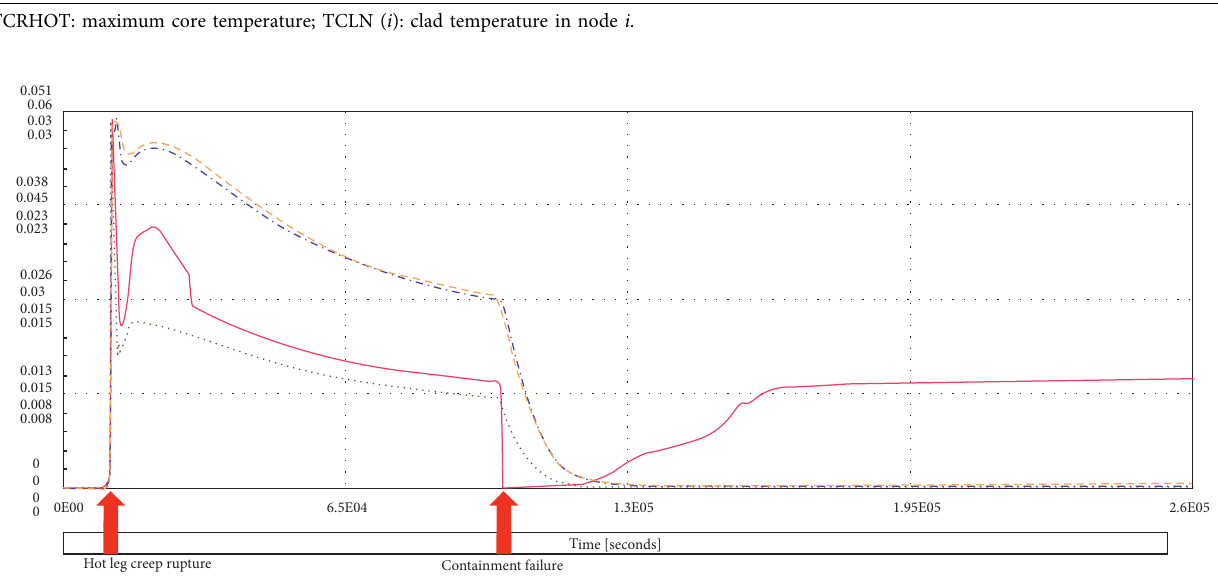
Figure 17: Hydrogen mole fraction in compartments: ① cavity (solid red), ② lower (dotted green), ③ upper (phantom blue), and ④ annular (dashed yellow). Table 16: Result of sensitivity study #7 (timing and flow rate of external